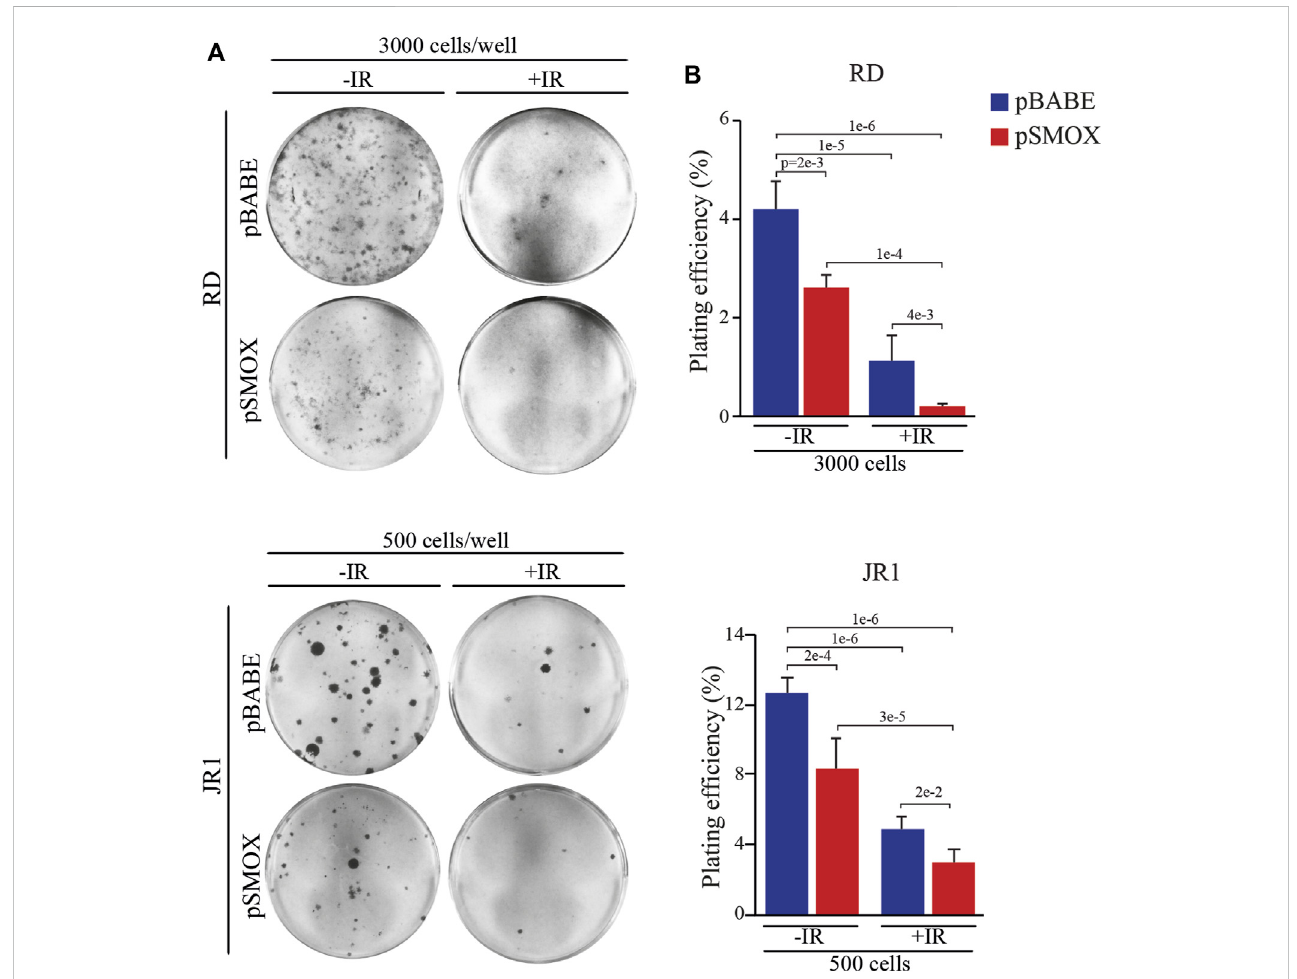
FIGURE 7 SMOX overexpression radiosensitizes FN-RMS cell lines. (A) Representative pictures of RD and JR1 colonies stained with crystal violet 12 days post seeding. FN-RMS cells were infected with either pBABE or pSMOX and 24 h later irradiated with 2 Gy. The cells were processed 3 h post irradiation. (B) Histograms depicting the plating ef fi ciency (%) of RD and JR1 infected with either pBABE or pSMOX and irradiated (+IR) or not (- IR) with 2 Gy. Graph represents the mean of three independent experiments ±SD, one-way ANOVA. Exact p -values are reported in the fi